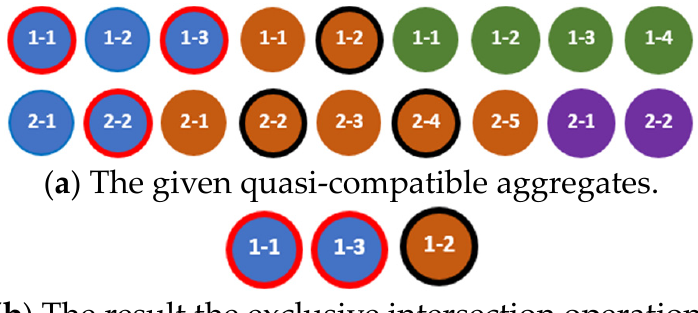
( b ) The result the exclusive intersection operation. Figure 9. An example of applying the exclusive intersection operation to two quasi-compatible ag- gregates.